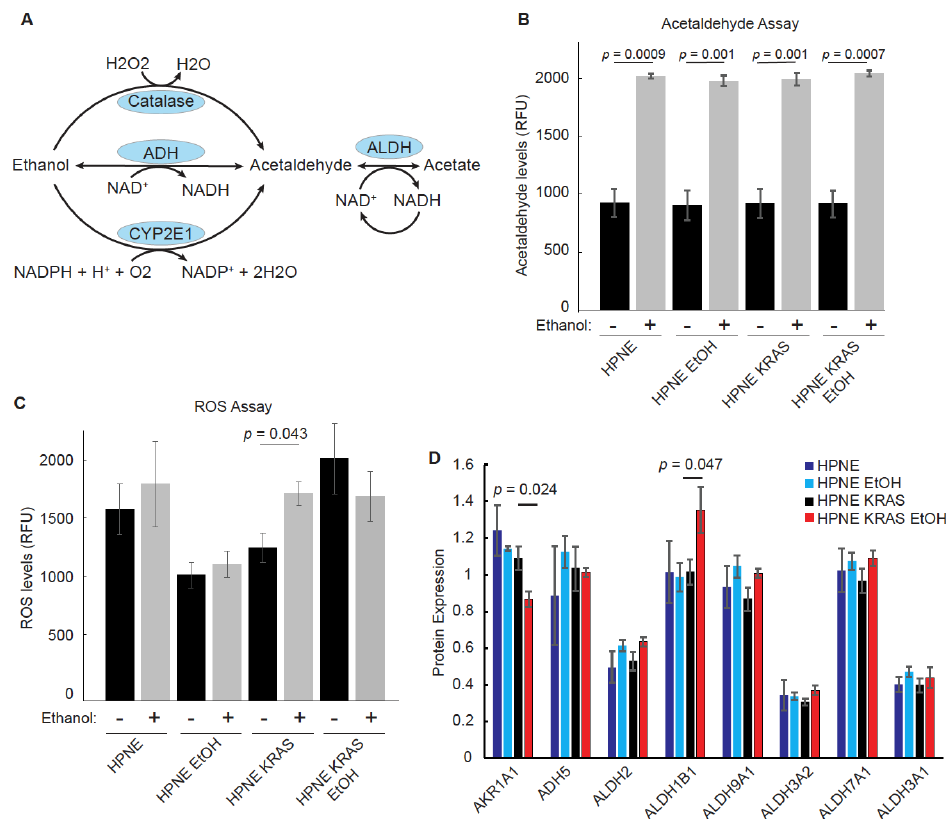
Figure 4. The effects of EtOH conditioning on ethanol metabolism in HPNE and HPNE-KRAS cells. ( A ) Simplified depiction of the ethanol metabolic pathway. Metabolites are in black text; enzymes are in blue circles. ( B ) Measurement of acetaldehyde abundance with and without acute EtOH exposure for 1 h in both the parental- and EtOH-conditioned HPNE and HPNE-KRAS cell lines. Mean ± SEM; n = 3. ( C ) Cellular Reactive Oxygen Species (ROS) measurements by DCFDA staining for the indicated cell line and treatment condition. Mean ± SEM; n = 3. ( D ) Protein expression of ethanol breakdown metabolism enzymes detected by quantitative TMT labeled proteomics. Mean ± SEM; n = 3. p -values were determined by Student’s t -test.